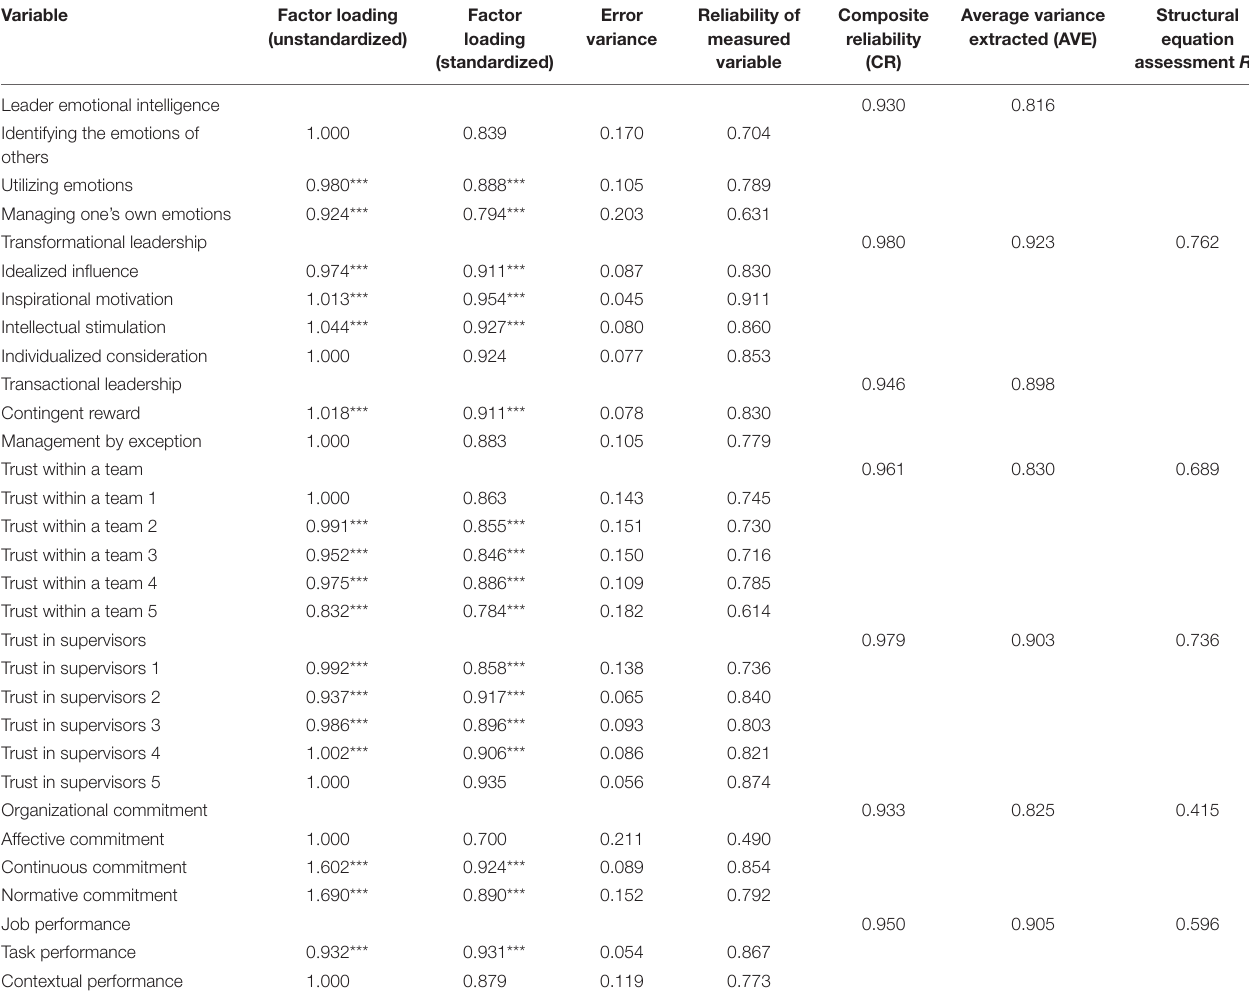
TABLE 4 | Analysis of the questionnaire’s reliability, factor loading, and average variance